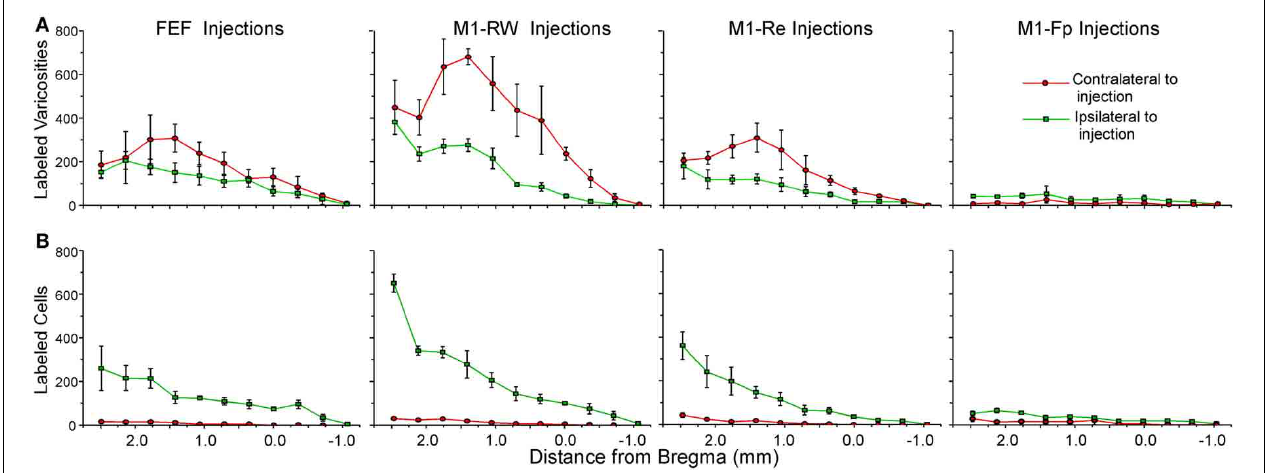
FIGURE 6 | Distribution of mean terminal and cell counts from tracer injections in different parts of rat motor cortex. (A) Labeled terminal counts in the ipsilateral and contralateral claustrum from BDA and FR injections in FEF and in the rhythmic whisking (M1-RW), whisker retraction (M1-Re), and forepaw (M1-Fp) regions from a